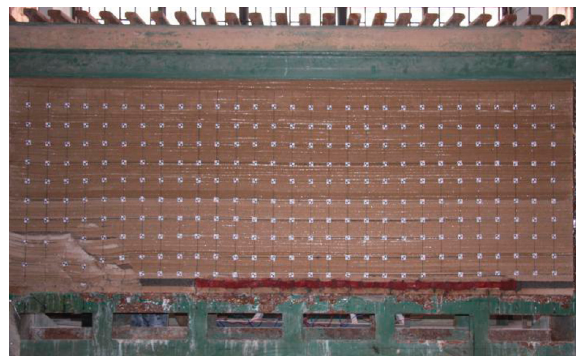
Figure 10: Final state after mining.